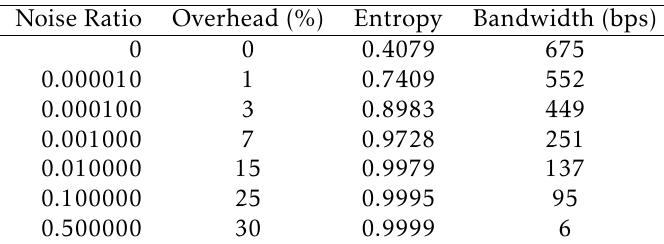
Table 4. Overhead and Accuracy on ARM